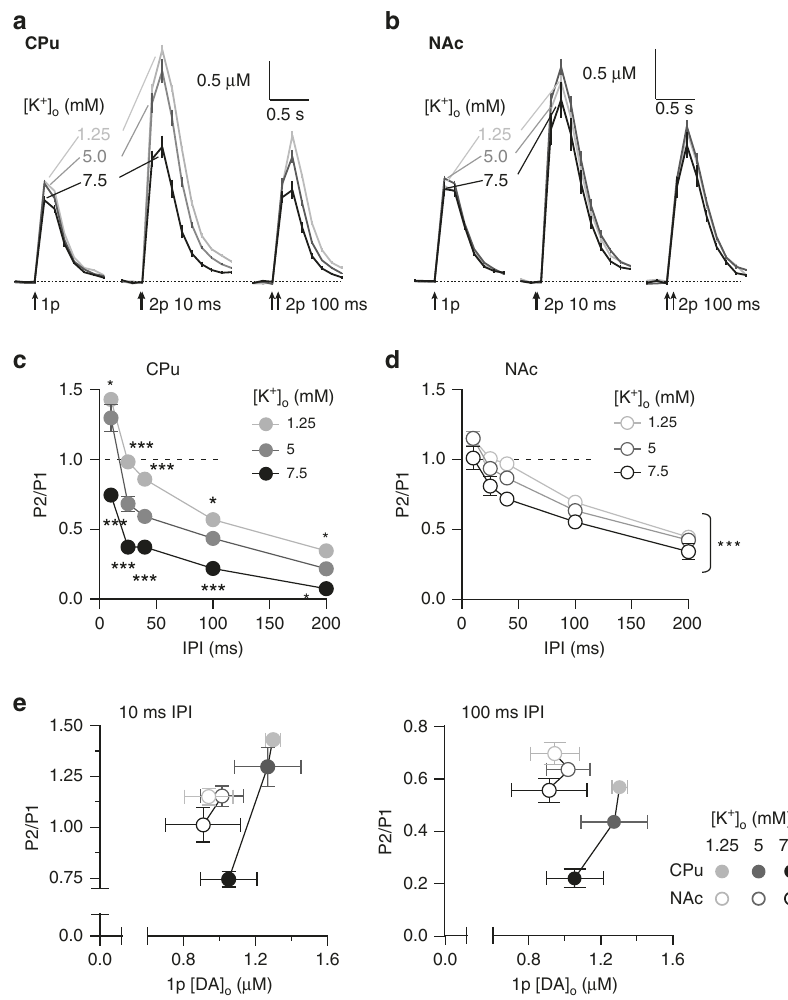
Fig. 3 A release-insensitive mechanism of short-term depression is controlled by [K + ]-dependent gating. a , b Mean pro fi les of [DA] o elicited by single or paired electrical pulses in 1.25 mM (light grey), 5 mM (dark grey) and 7.5 mM [K + ] o (black) in CPu ( a , n = 3) and NAc ( b , n = 3). c , d Mean P2/P1 (± SEM) vs IPIs in 1.25 mM (light grey), 5 mM (dark grey) and 7.5 mM [K + ] o (black) in CPu ( c ) and NAc ( d ). e Mean P2/P1 vs mean peak 1p [DA] o in 1.25 mM (light grey), 5 mM (dark grey) and 7.5 mM (black) [K + ] o in CPu ( fi lled) and NAc (open circles) at 10 ms IPI (left) and 100 ms IPI (right). Two-way ANOVA with Bonferroni ’ s test for post hoc comparisons; * P < 0.05, *** P < 0.001. Error bars are ± SEM. Source data are provided as a Source Data fi